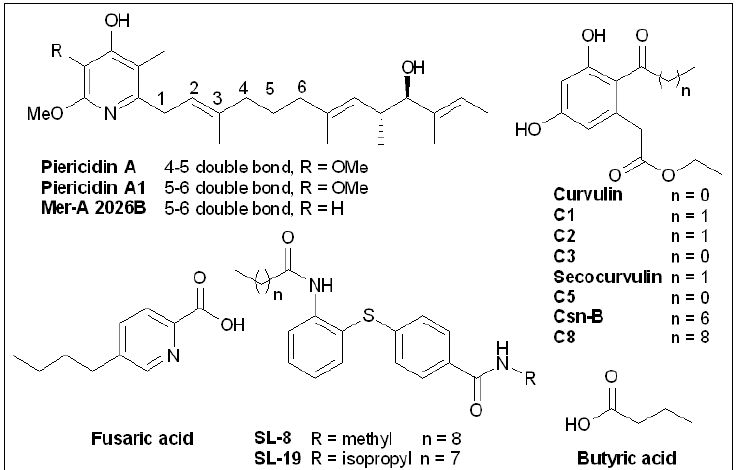
Figure 11. Structures of piericidins, Csn-B and derivatives, butyric acid, and fusaric acid and deriv-